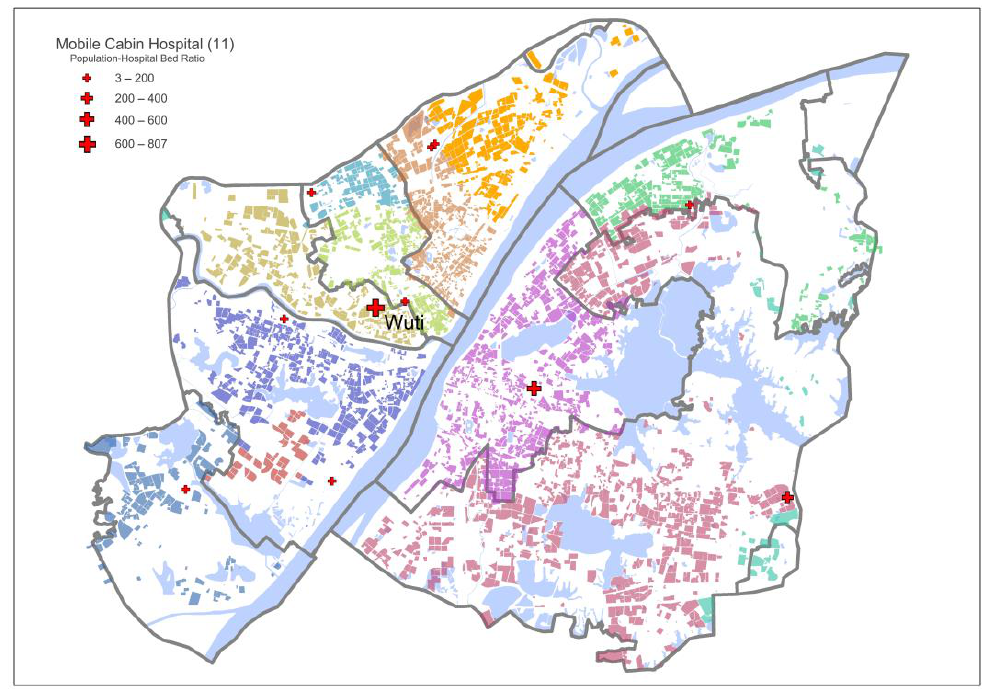
Figure 11. Service areas (in different colors) and population–hospital bed ratios (in different sizes) of the mobile cabin hospitals.